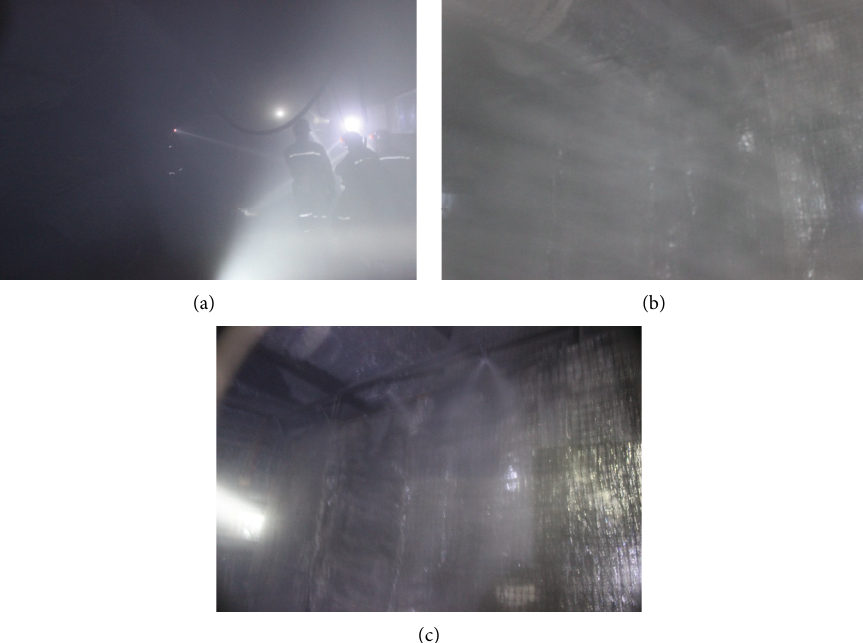
Figure 10: Effects of the SSC on the dust suppression in the Zhangcun Coal Mine. (a) Water curtain front. (b) Water curtain back without the SSC. (c) Water curtain back with the